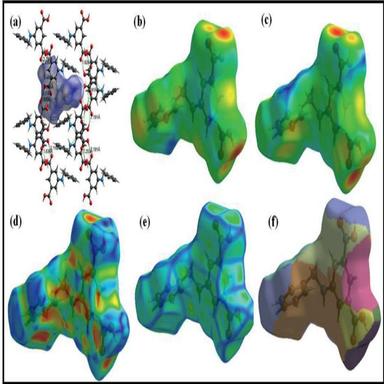
Hirshfeld surface for H2L mapped with dnorm(A), di (B), de (C), shape index (D) curvedness (E), Fragment patch (F).